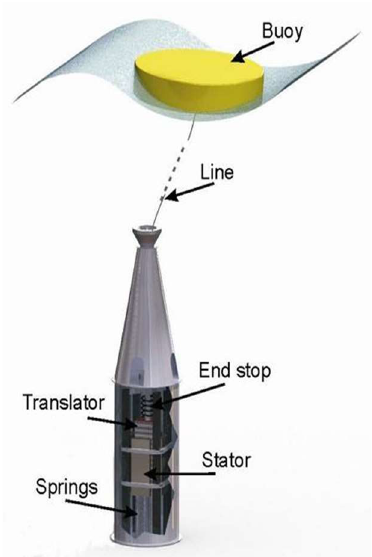
Figure 1. Comprehensive illustration of Uppsala University’s main WEC concept, comprising of a linear generator on the ocean floor, with a movable part (the translator) connected via a line to a buoy.